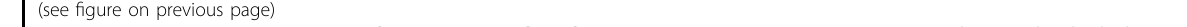
Fig. 6 miR-99a restrains progression and promotes autophagy by targeting mTOR. a miR-99a expression was downregulated at higher T stage (left panel, P = 0.003), N stage (middle panel, P = 0.030) or TNM stage (right panel, P = 0.014) in the TCGA cohort. b Kaplan – Meier analysis of the overall survival in the TCGA cohort based on miR-99a (HR = 0.672, P = 0.008). c , d miR-99a inhibited the proliferation ability of H1299 cells, as shown by colony formation assays ( c ) and EdU assays ( d ). e miR-99a inhibited the migration and invasion abilities of H1299 cells, as shown by transwell and Matrigel assays. f – h miR-99a promoted autophagy in H1299 cells, as shown by WB assays ( f ), TEM ( g ), and autophagic fl ux ( h ). i The schematic diagram of the binding site of mTOR and miR-99a which was predicted by TargetScan (http://www.targetscan.org/vert_72/), and the schematic diagram of wild type or mutant mTOR sequence used for dual luciferase reporter assays. Dual luciferase reporter assays indicated that miR-99a directly binds to the 3 ’ -UTR of mTOR ( P = 0.001). j Western blot analysis indicated the change in mTOR expression level in H1299 cells transfected with miR-99a mimics or inhibitors. k qRT-PCR showed that miR-99a overexpression decreased the mRNA expression of mTOR in H1299 cells ( P < 0.001). l Correlation between miR-99a expression and mTOR expression in the 30-patient cohort ( r = − 0.363, P = 0.048). All experiments were repeated three times with similar results and images are representative of three independent experiments. A two-tailed Student ’ s t -test was used for statistical analysis. * P < 0.05, ** P < 0.01, *** P < 0.001, n.s. not statistically signi fi cant. Error bars,